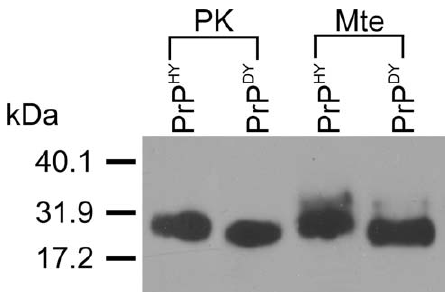
Figure 4. Maintenance of Strain Properties for Mte-Associated PrP TSE BH from hamsters clinically affected with either HY or DY agents were incubated with Mte to allow binding. Desorbed proteins were analyzed by SDS-PAGE and immunoblotting. Cleavage patterns of PrP HY and PrP DY extracted from Mte parallel PK cleavage patterns for the respective proteins: cleaved PrP DY migrates further (corresponding to a 1- to 2-kDa molecular mass difference) than cleaved PrP HY . Immunoblot used the PrP-specific antibody 3F4.